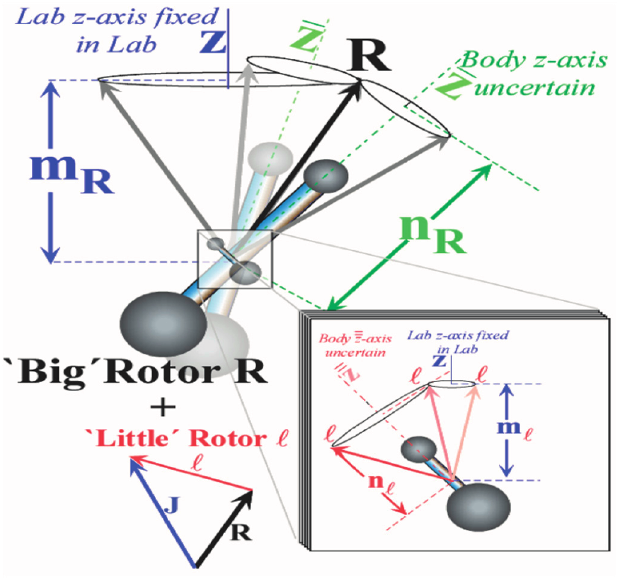
Figure 1. Schematic of coupled rotor system taken from [7]. The angular momentum J , R , and ℓ are shown along with their projection of the lab and body